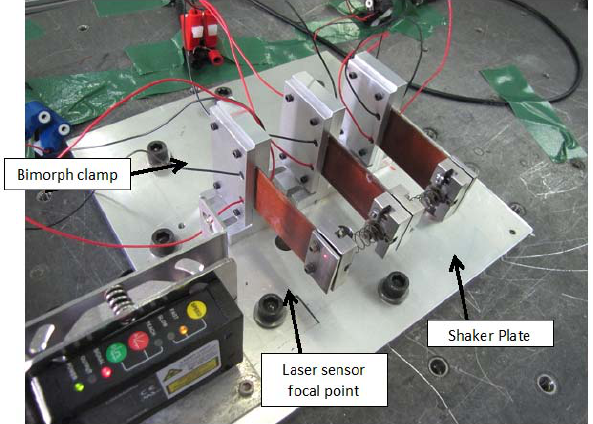
Figure 6. The three bimorphs system the experimental system setup.